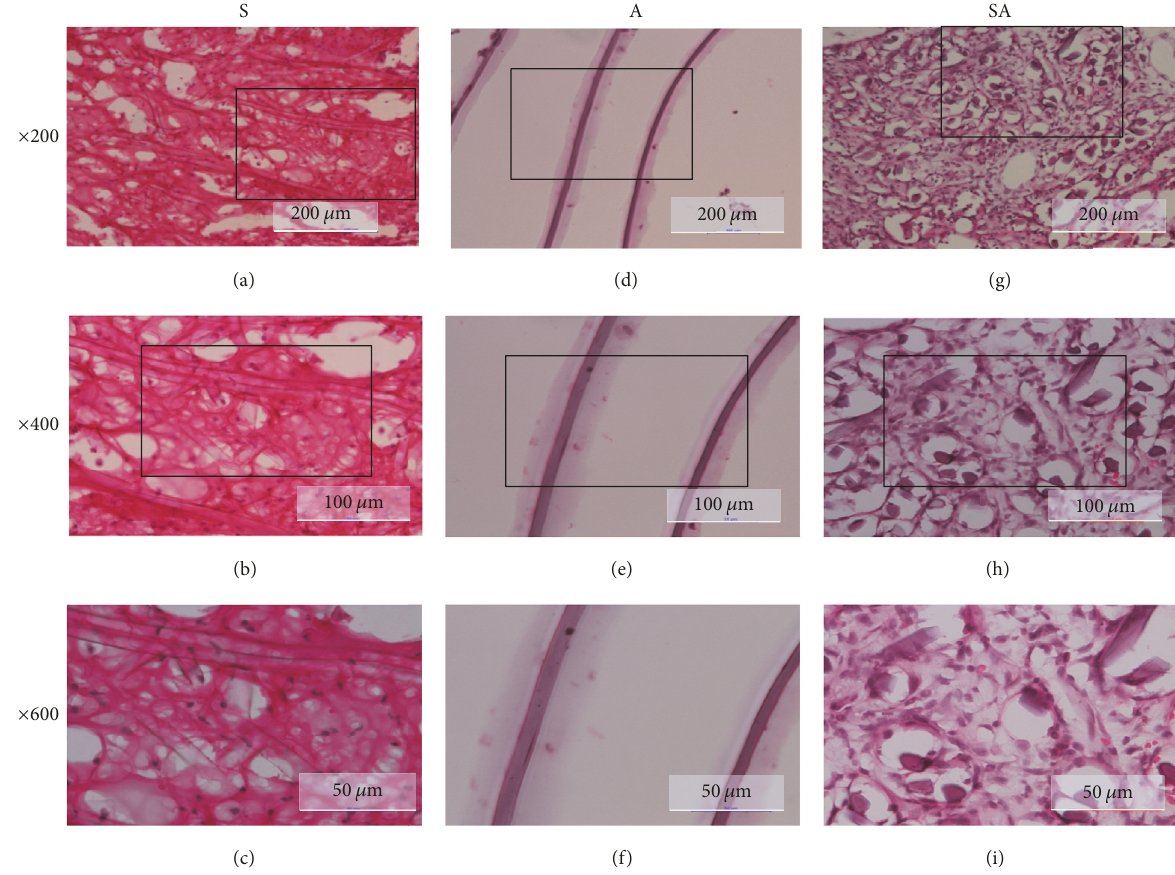
Figure 5: H&E staining of implanted sample after 15 days: (a, b, c) S scaffold, (d, e, f) A scaffold, and (g, h, i) SA scaffold, at 3 magnifications: × 200, × 400, and ×